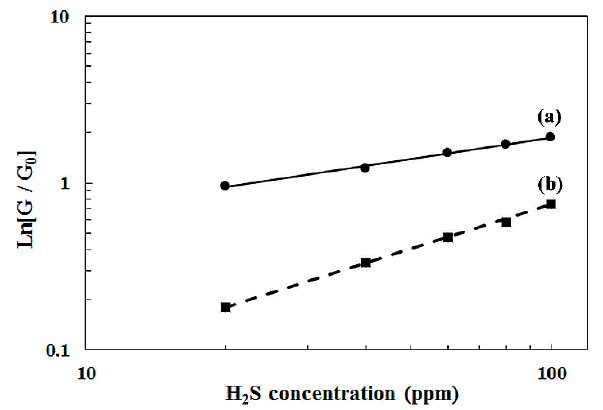
Figure 8. Sensitivity of sensor-400 (a) and sensor-500 (b) versus the H 2 S concentration at 350 °C. The dots are experimental values. The lines are the fitting curves obtained with Equation (10).